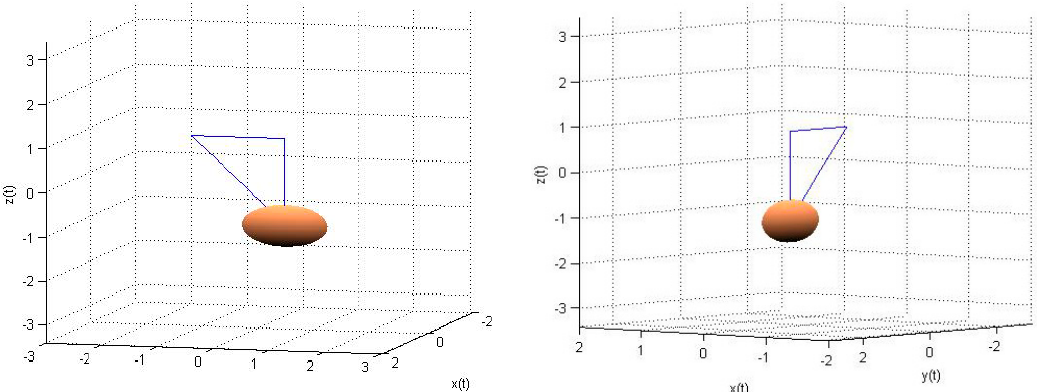
Figure 8. Trajectory of the larynx evaluated by the Matlab code for swallowing.